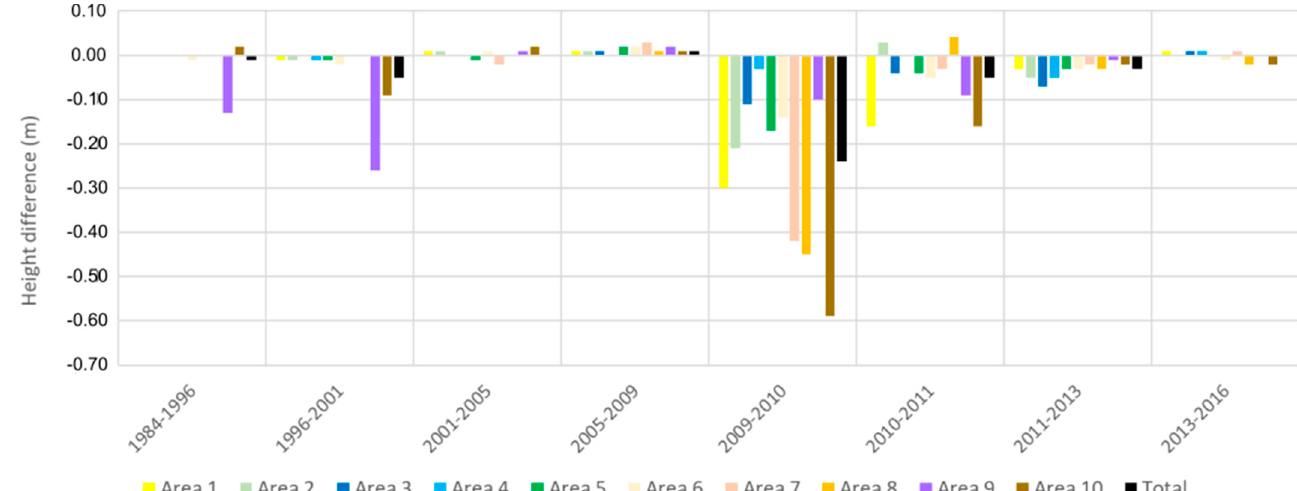
Figure 12. Evolution of height differences throughout the different periods.